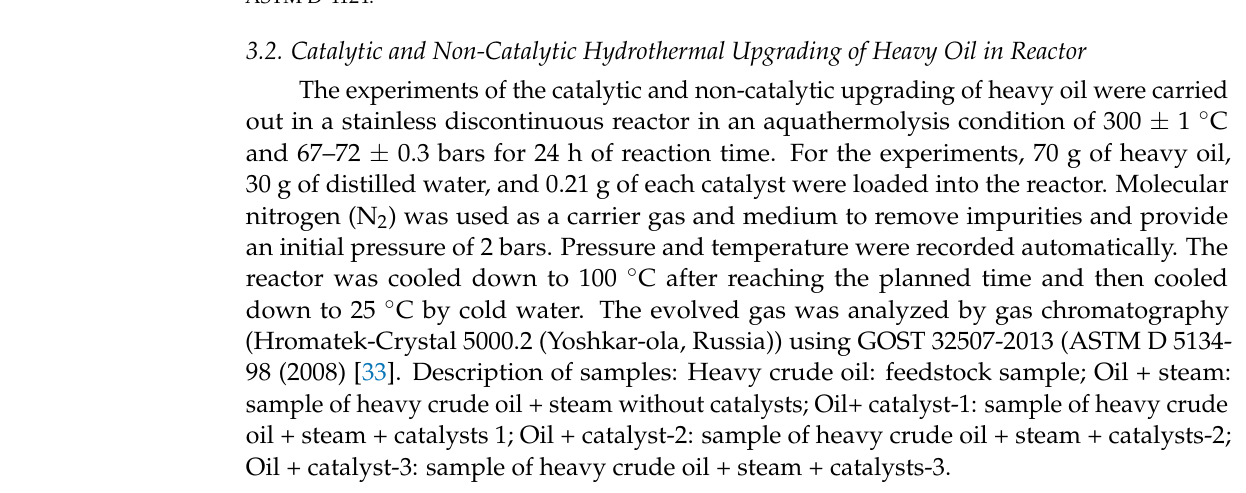
Figure 7. BJH Adsorption and desorption of the pore volume of catalyst - 3.